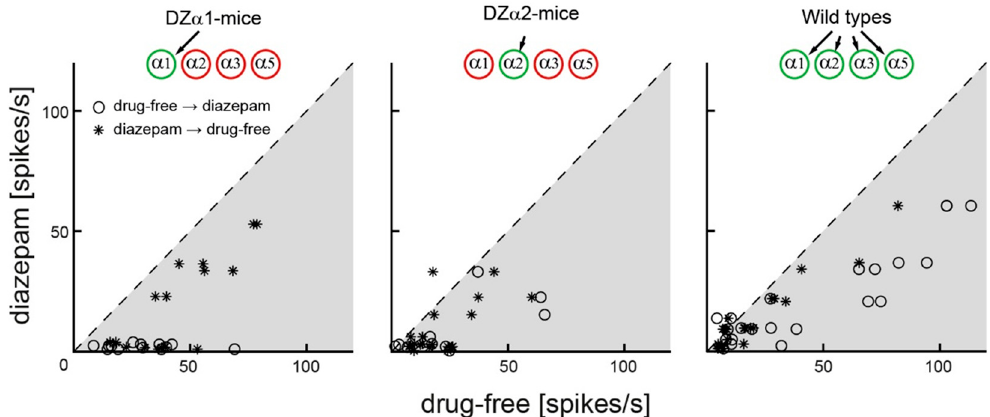
Figure 4. Spikes per second under diazepam (ordinate) plotted versus spikes under drug-free conditions (abscissa) for all three genotypes. The broken lines represents identity of discharge rates and the grey-shaded area a decrease in action potential activity under diazepam. Diazepam attenuated spontaneous action potential firing in all genotypes. This effect is independent of whether the drug-free session was recorded before (circles) or after the diazepam session (asterisks).